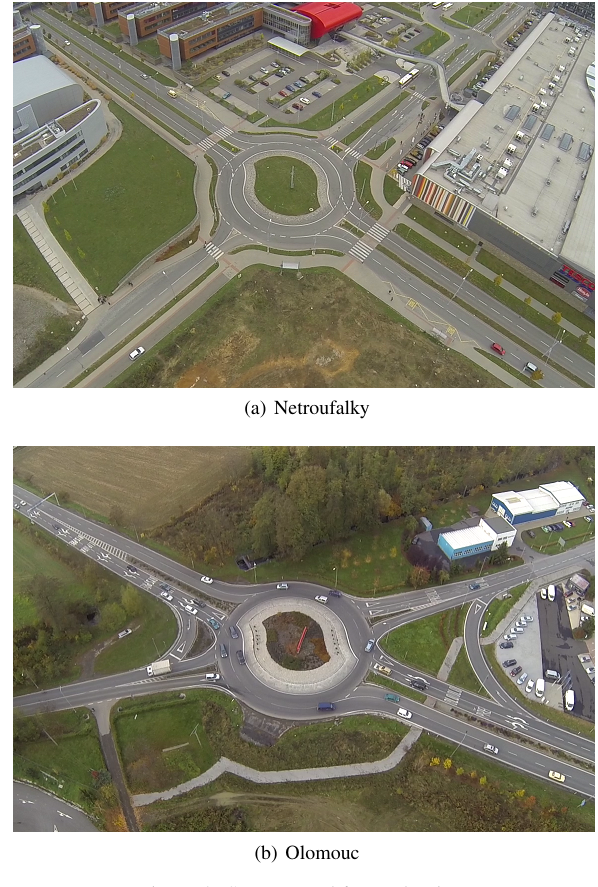
Figure 3. Scenes used for evaluation.